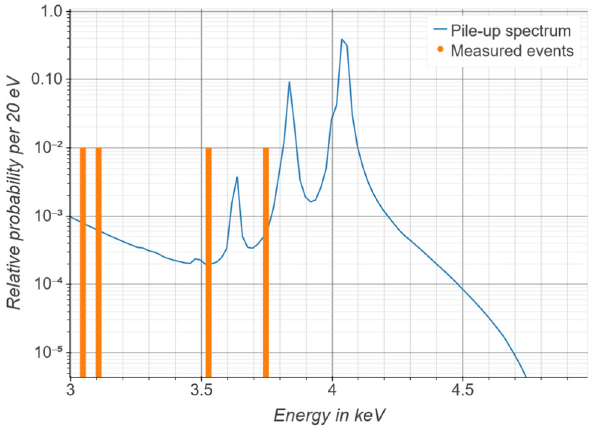
Fig. 13 Normalized energy spectra of unresolved pile-up and mea- sured events in 241 pixel-days